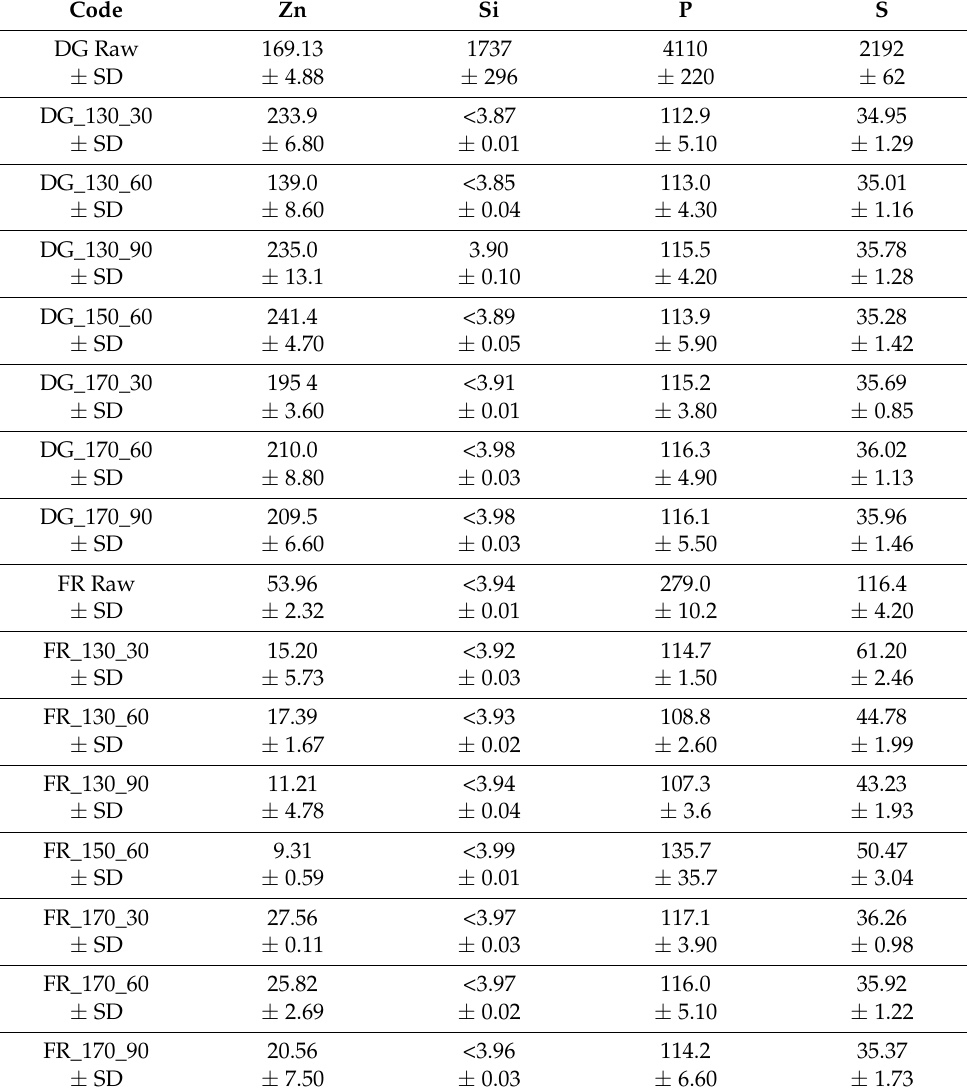
Table A5. Mean values ± standard deviations (SD) for different element concentrations in the digestate (DG) and forest residue (FR) hydrothermally treated at 130, 150 or 170 ◦ C with a holding time of 30, 60 or 90